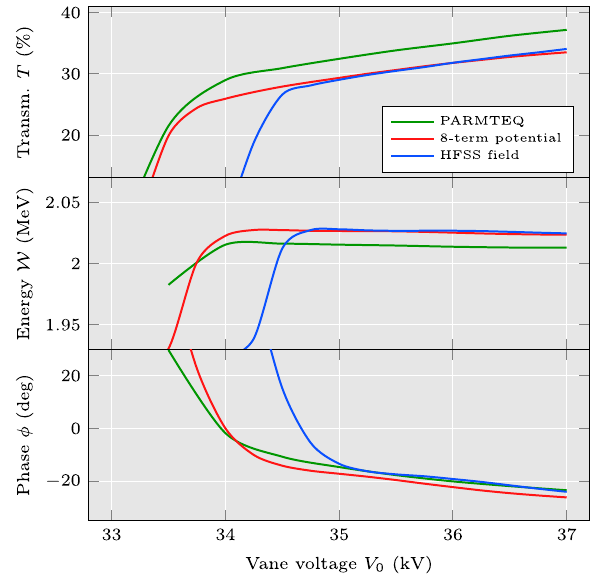
FIG. 18. Transmission, final energy, and final synchronous phase as functions of the vane voltage for the three investigated field